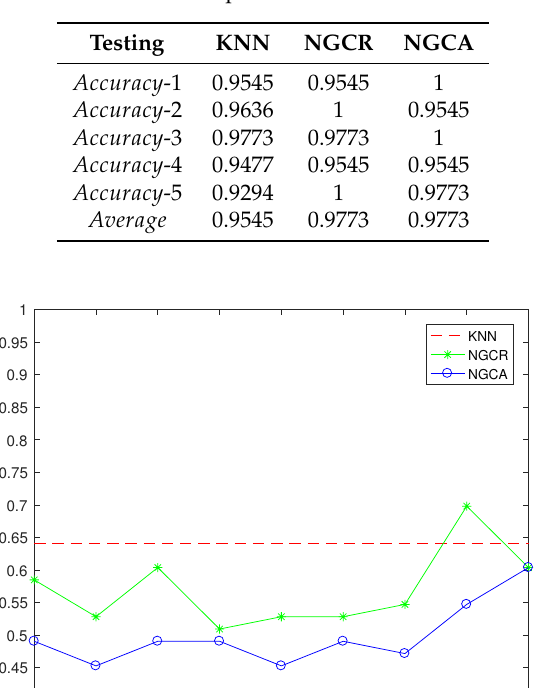
Table 3. Classification experiment results for Wine data set.